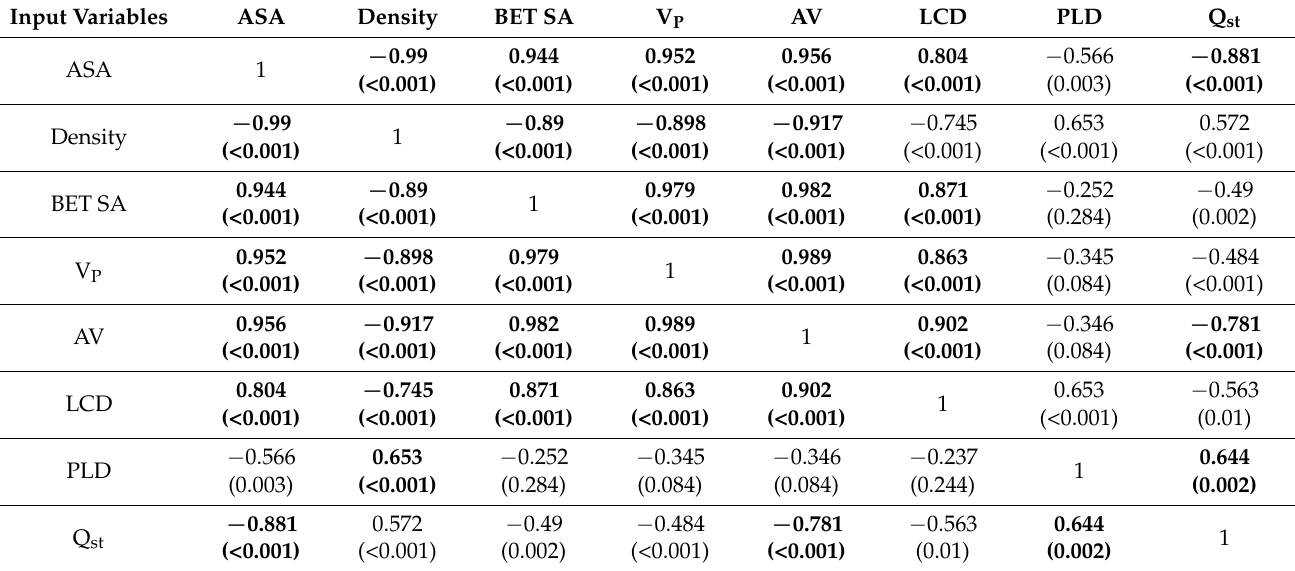
Table 3. Intra-input Pearson’s correlations for the material, thermodynamic, and pore properties of the 83 MOFs used in this